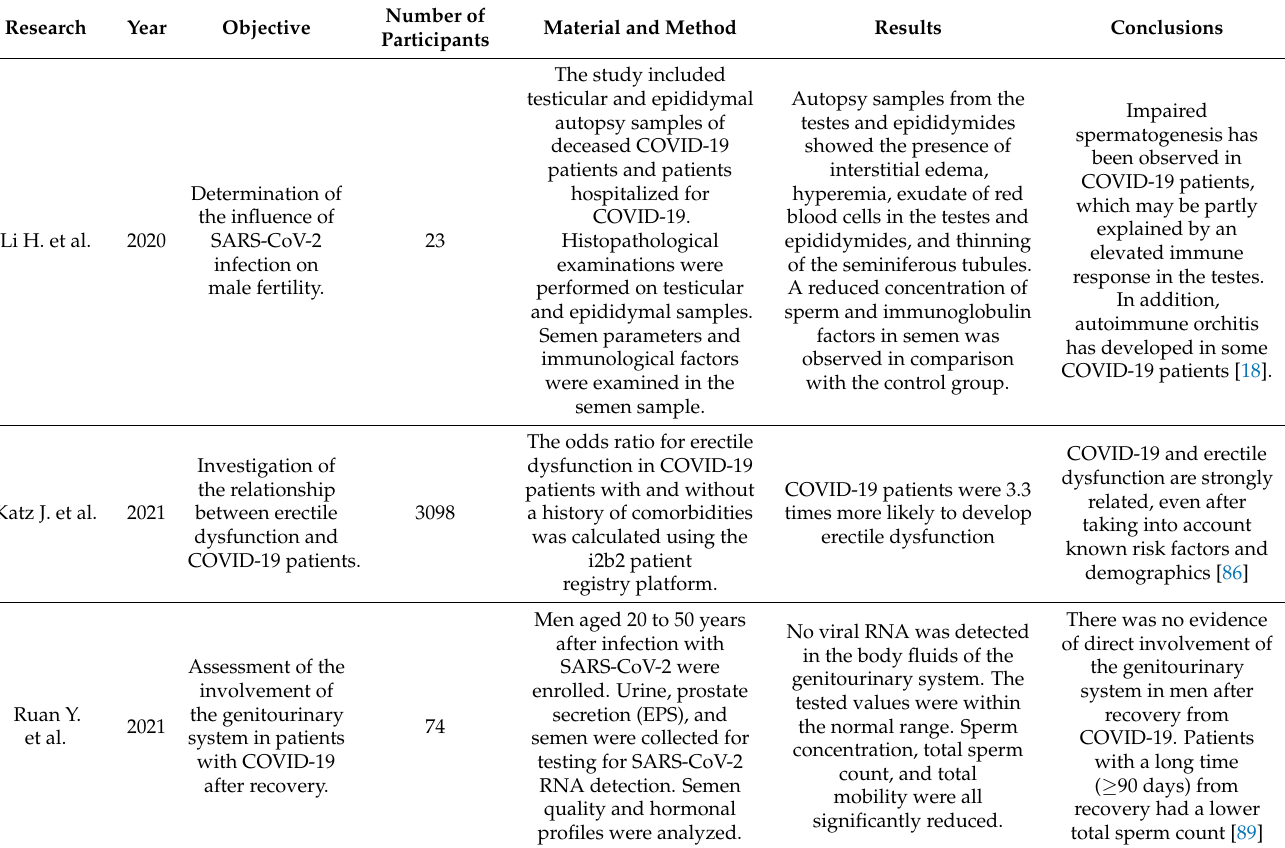
Table 6. The main effects of COVID-19 on the reproductive